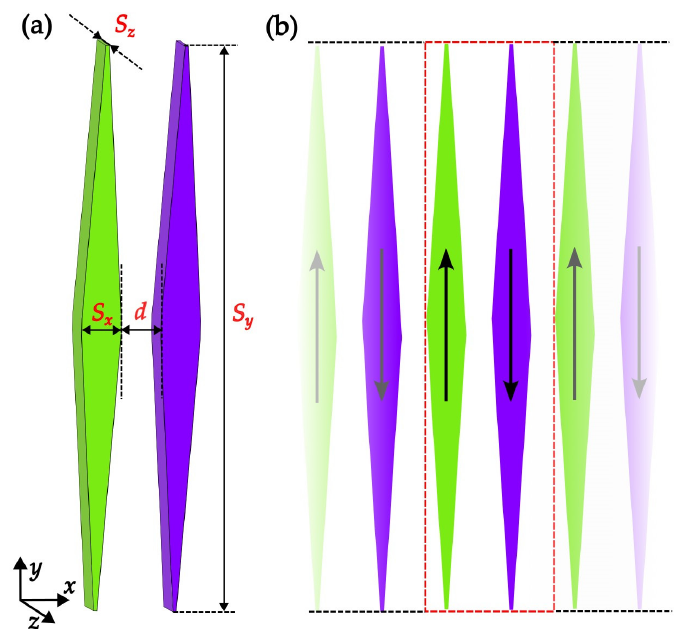
Figure 1. ( a ) Schematic representation of a pair of parallel elongated diamond-shaped nanoparticles. The distance d concerns the lateral apices of the diamonds. ( b ) Sequence of considered nanoparticles arranged in a linear chain. The arrows indicate magnetization directions within each object in the ground state.